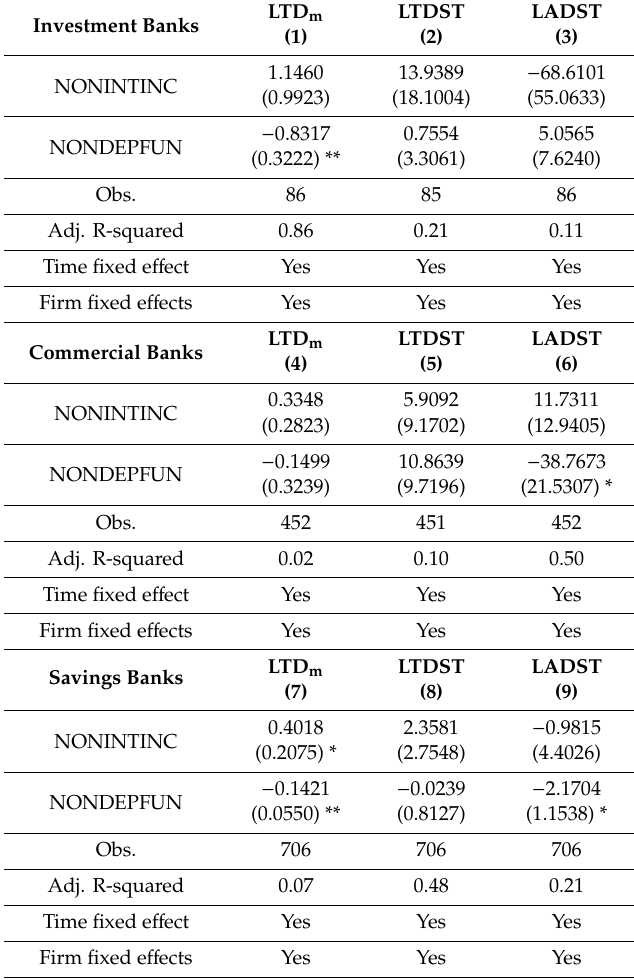
Table 4. Bank business models’ fixed-e ff ects panel